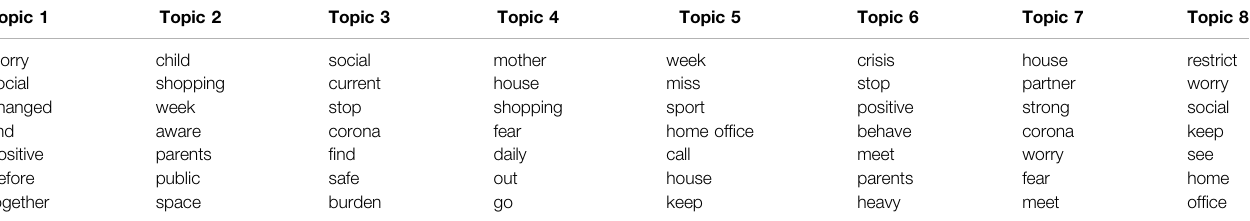
TABLE 6 | Topics of those in shared living without children (n (cid:1) 493). Topic 1